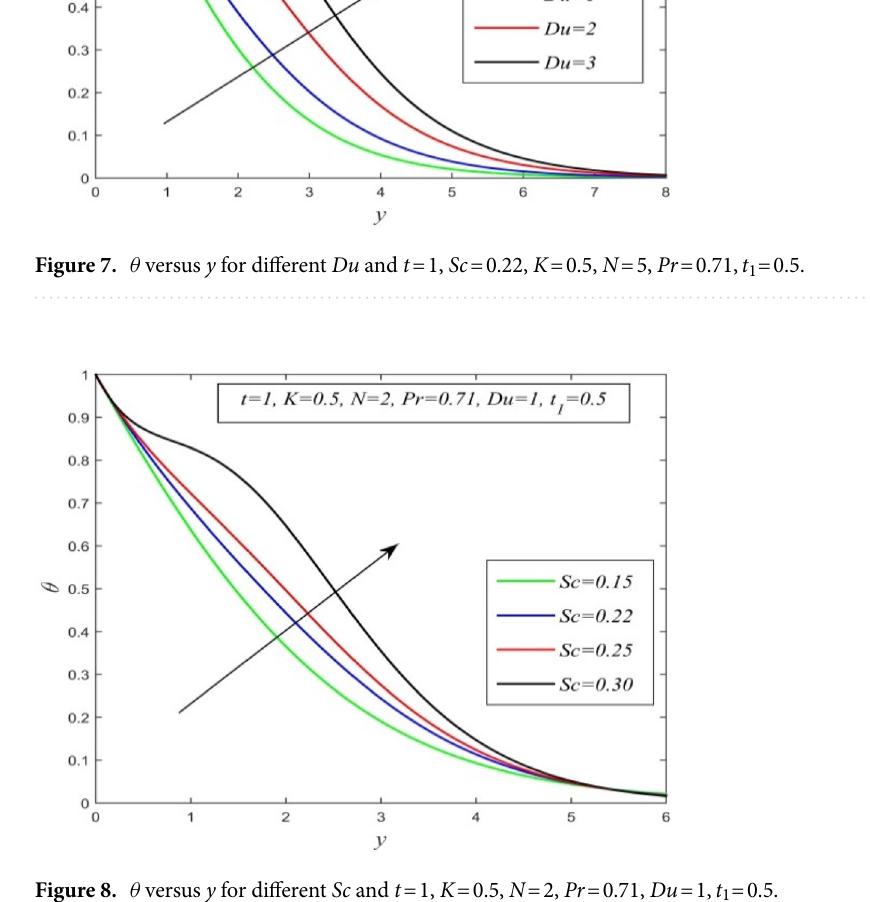
Figure 8. θ versus y for different Sc and t = 1, K = 0.5, N = 2, Pr = 0.71, Du = 1, t 1 =